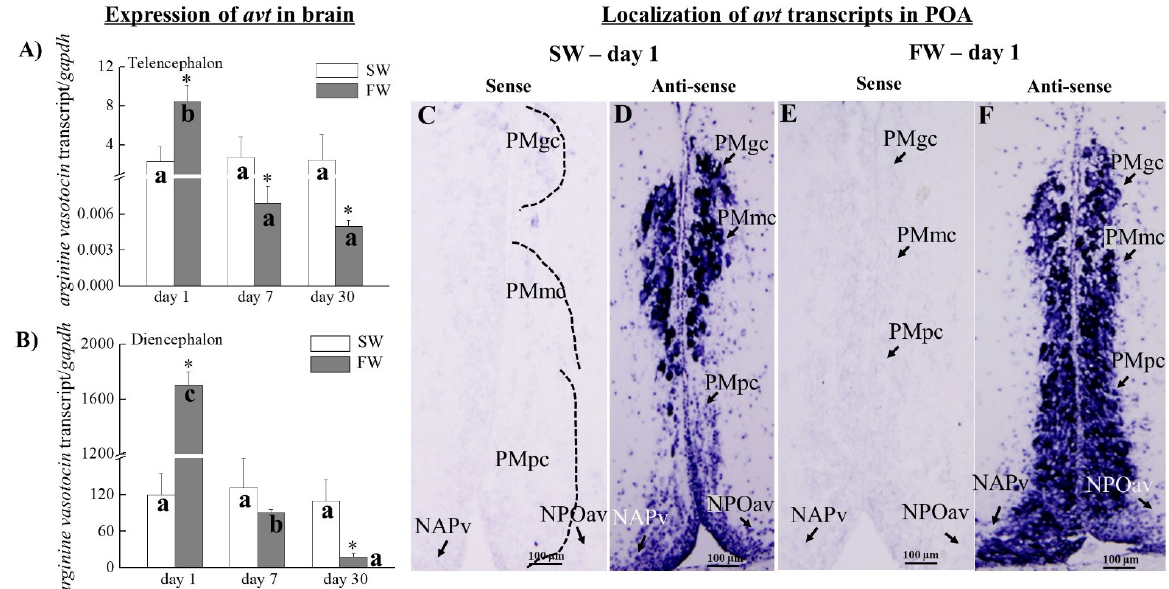
Figure 4. Q-PCR was performed to analyze the transcripts of avt in the telencephalon ( A ) and diencephalon ( B ) of SW and FW black porgies on day 1, day 7, and day 30 ( n = 8 in each group). Gene expression was normalized to the control ( gapdh ) gene. The results are expressed as mean ± SEM. Different letters indicate a significant difference between sampling points with the same treatment; asterisks (*) show differences between groups at the same time point (two-way ANOVA followed by Tukey’s test, p < 0.05). ( C – F ) Localization of avt transcripts in SW and FW black porgies’ preoptic areas (POA) on day 1 ( n = 4 in each group). The transcripts of avt ( D , F ) were detected in both SW and FW fish. Furthermore, the avt transcripts were increased in PMmc and PMpc of the FW fish ( F ) compared to the SW fish ( D ). No difference was found between SW ( D ) and FW ( F ) fish in PMgc on day 1. One of the representative fish from each group was used for the histological data. There were no signals detected in the SW ( C ) and FW ( E ) fish when using the respective control sense probes of avt on day 1. PMgc: preopticus parvocellularis of pars gigantocellularis; PMmc: preopticus parvocellularis of pars magnocellularis; PMpc: preopticus parvocellularis of pars parvocellularis; NAPv: nucleus anterioris periventricularis; and NPOav: ante- roventralis nucleus preopticus. 3.4. Localization of avt Transcripts in the SW and FW Black Porgies’ Preoptic Areas In situ hybridization was performed to localize the avt transcripts (Figure 4C–F) in the SW and FW black porgies’ POAs. Transcripts from avt were detected in the POAs of both SW and FW black porgies. Furthermore, the levels of the avt transcripts were in- creased in the preopticus parvocellularis of pars magnocellularis (PMmc) (Figure 4F) and the preopticus parvocellularis of pars parvocellularis (PMpc) (Figure 4F) of the FW fish on day 1 compared to the SW fish (Figure 4D). The preopticus parvocellularis of pars gi- gantocellularis (PMgc) revealed no differences between the SW (Figure 4D) and FW fish (Figure 4F) on day 1. There were no signals in the SW and FW fish when using the respec- tive control sense probes of avt on day 1 (Figure 4C,E). 3.5. The Expression of avtr Transcripts in the Pituitary The transcripts of avtr were detected in the pituitary (Figure 5A). The avtr transcripts were significantly increased on days 1, 7, and 30 in the pituitary of the FW fish when compared to the SW controls (increased by 4.2-fold, 2.2-fold, and 1.8-fold on days 1, 7, and 30, respectively; Figure 5A). Among the FW fish groups, the avtr mRNA was significantly decreased on day 7 and day 30 compared to the FW fish on day 1 (Figure 5A).